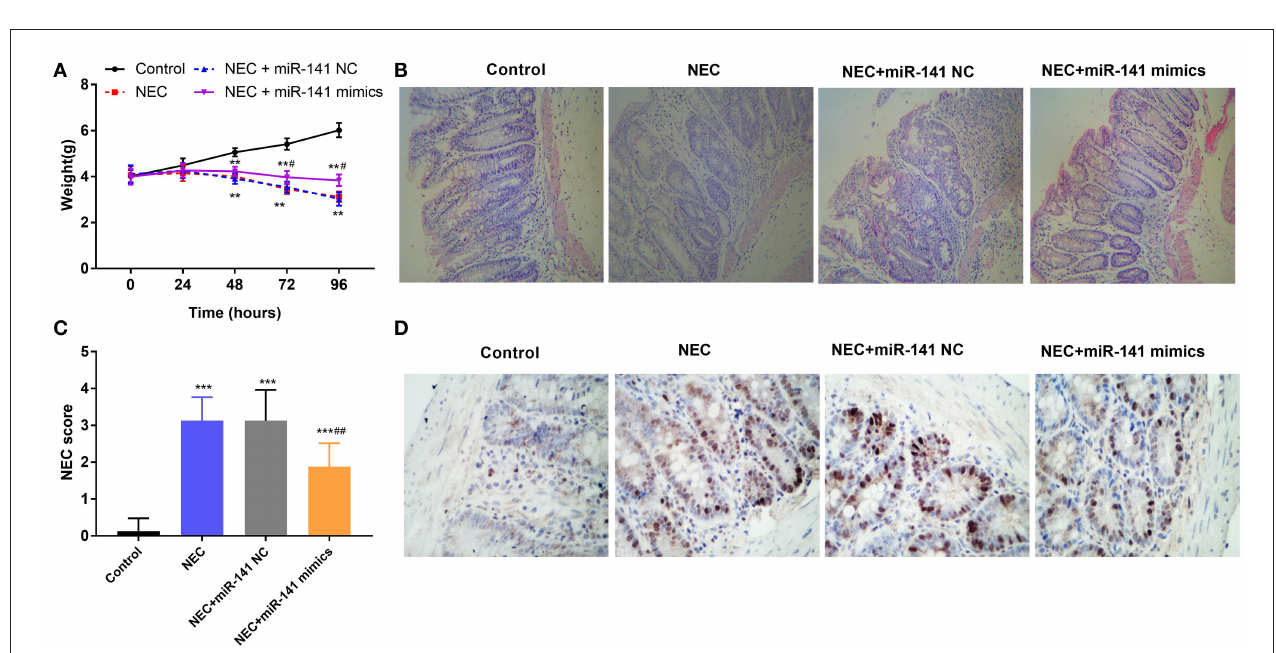
FIGURE 2 | MiR-141-3p eased the damage to intestinal tissues in NEC. After establishment of the NEC model and transfection with miR-141 mimics/miR-141 NC vectors, (A) the weight changes of experimental mice ( n = 8) in different groups were measured; (B) the intestinal histopathological changes were observed via hematoxylin and eosin (H&E) staining; (C) the intestinal histopathology NEC score was analyzed; (D) the cell apoptosis from NEC tissues was assessed through TUNEL assay. ** P < 0.01, *** P < 0.001 in comparison with the Control group; # P < 0.05, ## P < 0.01 in comparison with the NEC group or NEC + miR-141 NC.